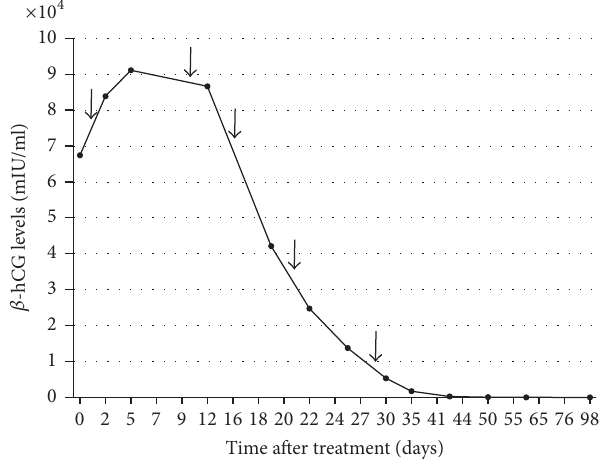
Figure 1: Curve of serum 𝛽 -hCG levels for case 1 . Arrow indicates MTX administration.